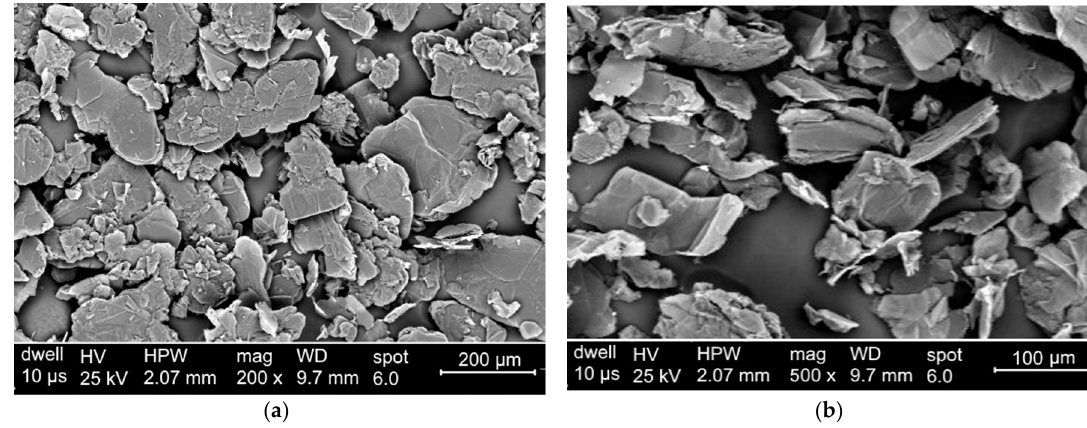
Figure 8. Scanning electron microscope (SEM) images showing the microstructure of graphite flakes after beneficiation processes at: ( a ) low magnification; ( b ) highest magnification.